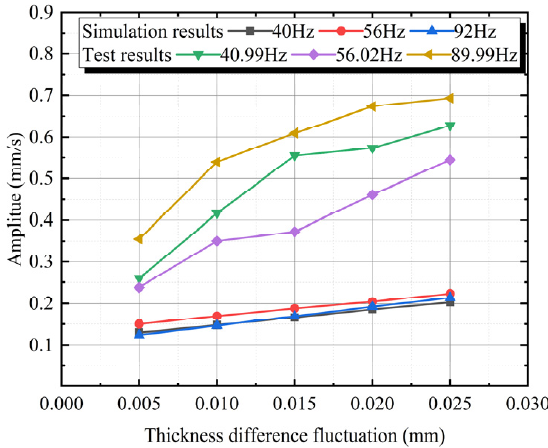
Figure 15. Plate thickness affects axial vibration.